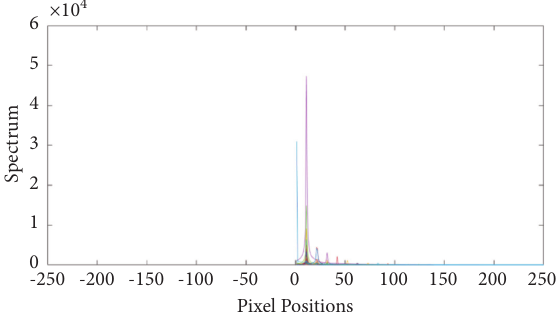
Figure 5: Uncorrected gamma � 0.80, spectrum display diagram.